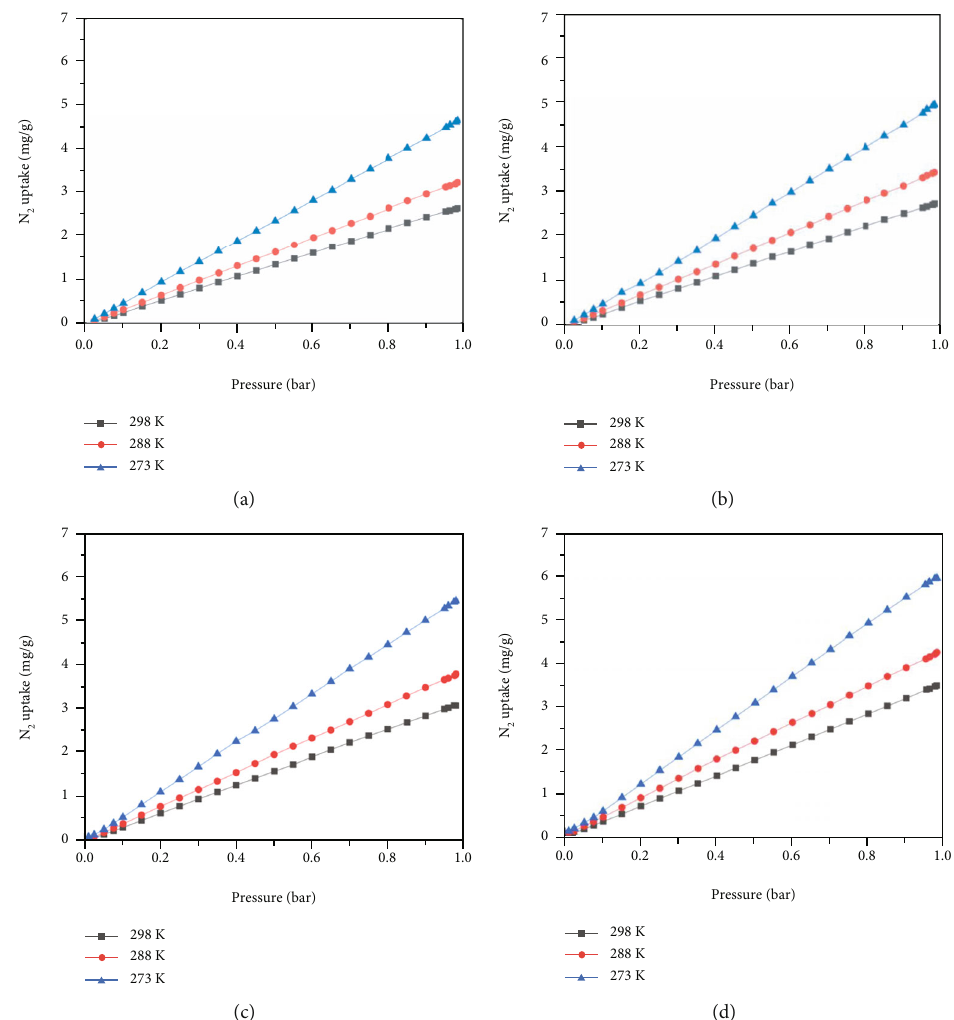
Figure 6: The N adsorption isotherms on the amine@ZIF-8 materials at 273K, 288K, and 298 K. (a) ZIF-8; (b) MA-ZIF-8; (c) ED-ZIF-8; 2 (d)